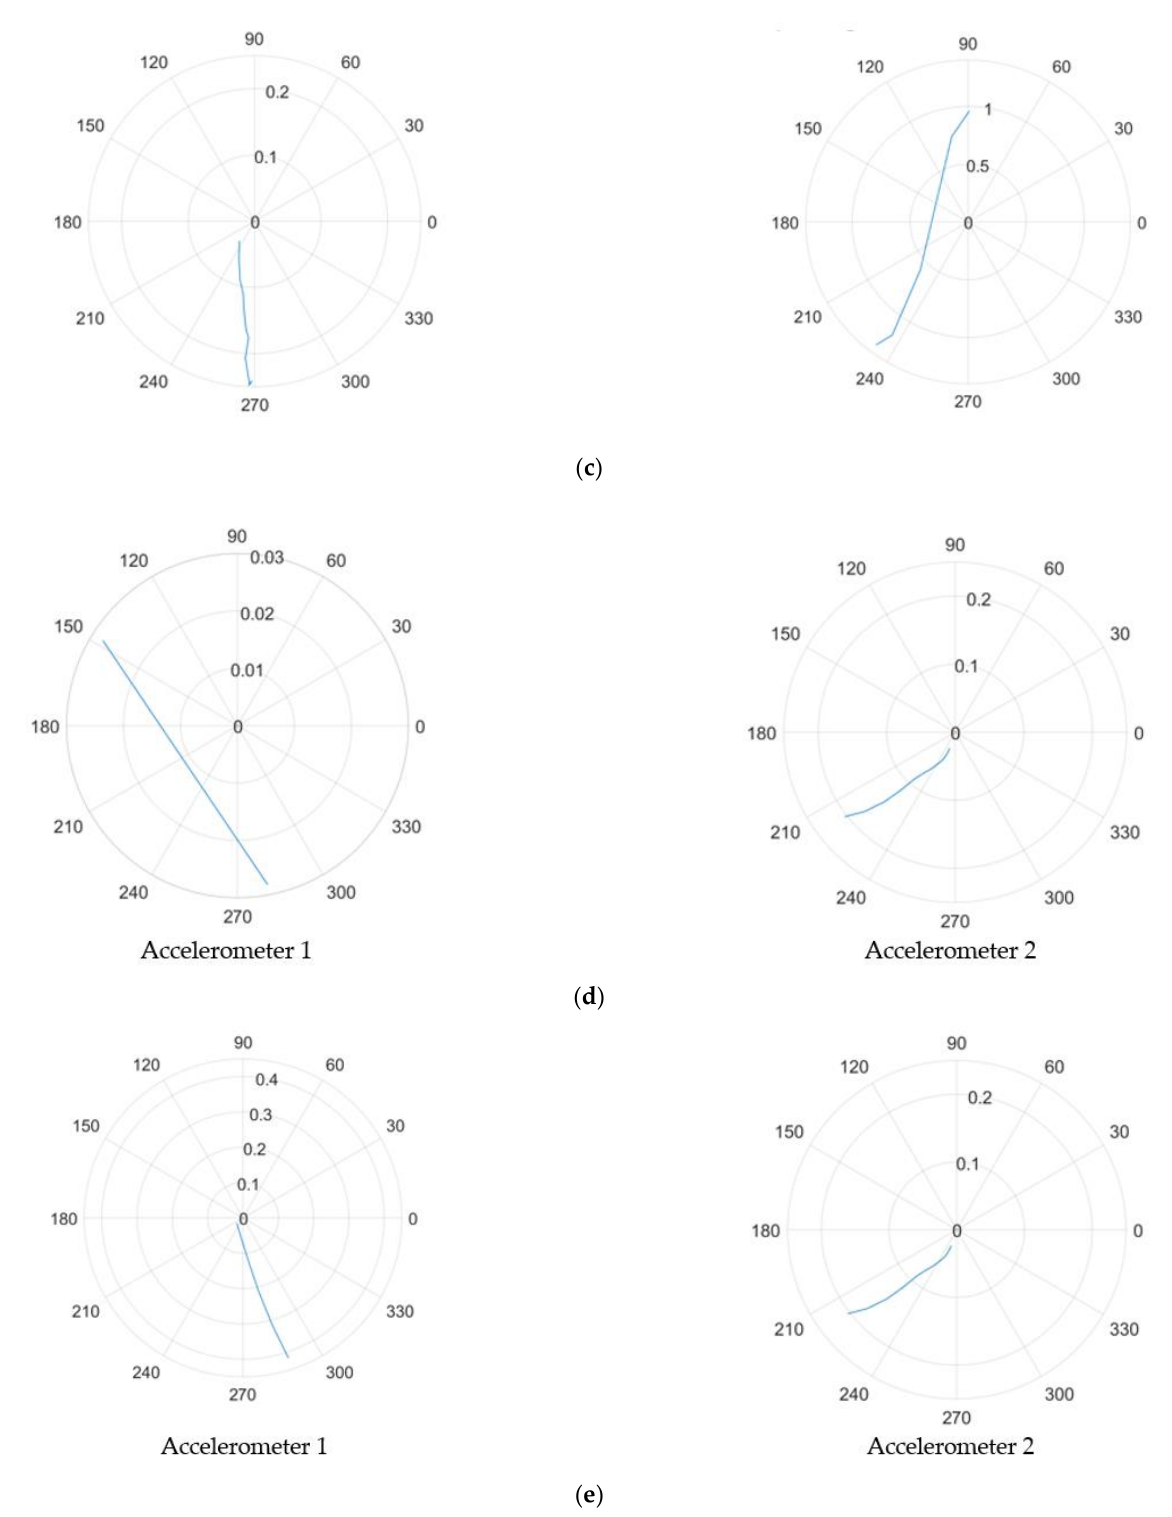
Figure 10. Hodogram analysis for various stages of macrocracks of the plain SCC beam: ( a ) amplitude–time curves highlighting the analysed sections; ( b ) hodograms for Stage 1 macrocrack; ( c ) hodograms for Stage 2 macrocrack; ( d ) hodograms for Stage 3 macrocrack; and ( e ) hodograms for Stage 4 macrocrack.